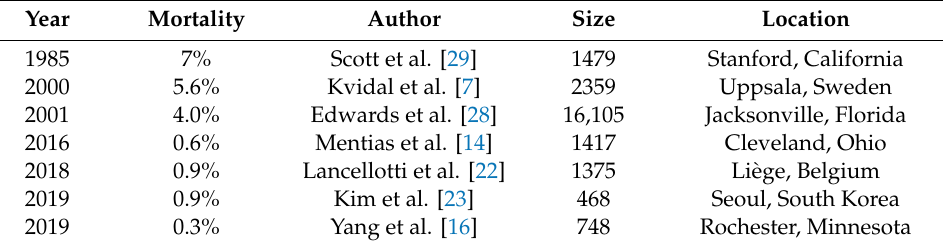
Table 5. Reported perioperative mortality rates from AVR over the last 30